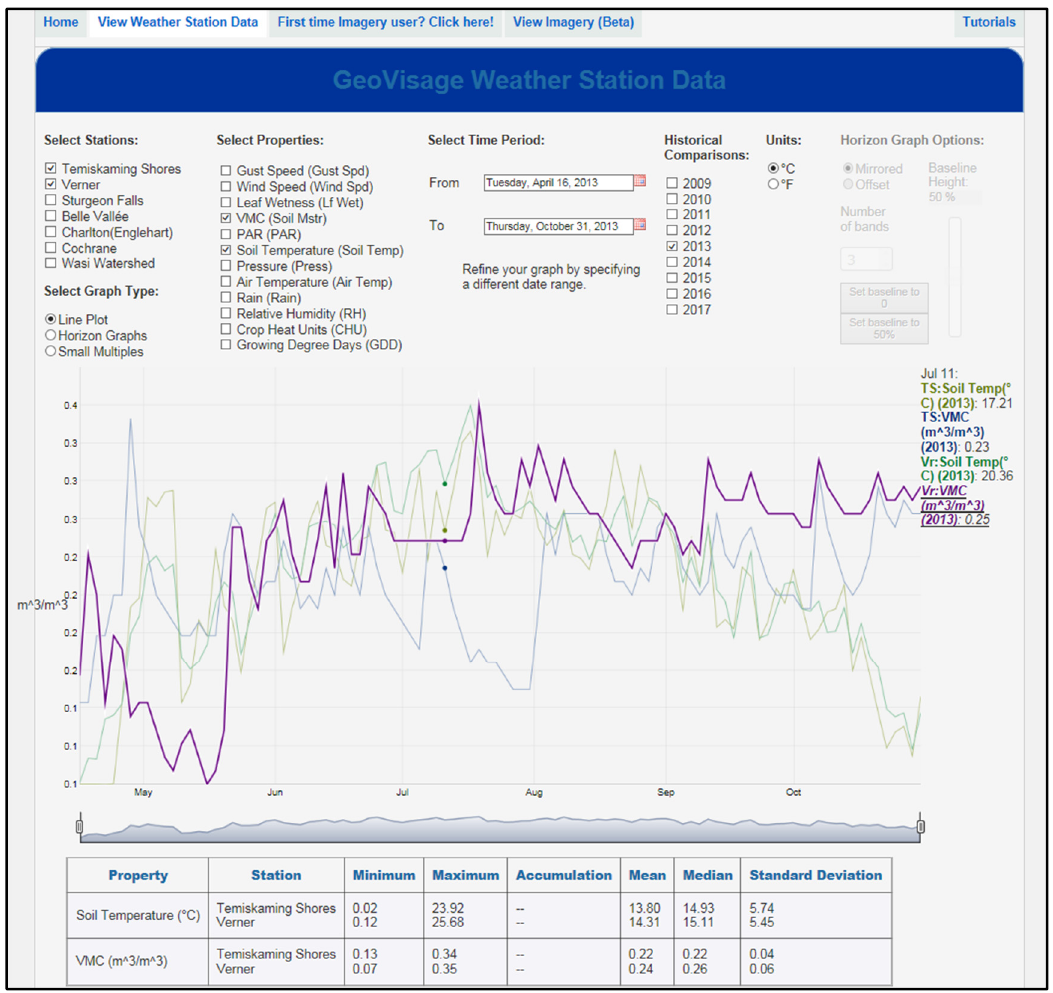
Figure 3. Interface for weather station data. Time series for two environmental properties (soil temperature and volumetric moisture content), comparing two sites (Verner and the more northern Temiskaming Shores region) over a growing season. The time selector below the line plot allows time zooming. Hovering over a time series displays the sensor readings for a specific time and date. The statistics panel is located below the selector.